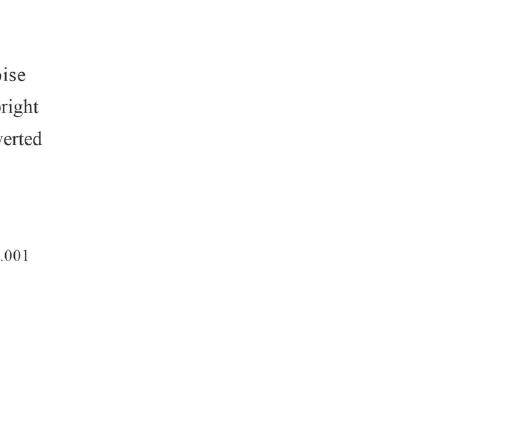
Figure 7. Group*Response interaction for the Toast test. Post-hoc contrasts based on Response. Upper part of the figure: RTs of pareidolia responses versus noise detections were not significantly different in the 40Hz-tACS_ PRE group, while participants in the Sham and 40Hz-tACS_ON groups exhibited differential performances (i.e., significantly faster RTs for face detections vs. noise detections); bottom part of the figure: differences (in absolute values) between noise detections’ and face detections’ RTs among groups (40Hz-tACS_PRE =|6|; Sham =|16|; 40Hz-tACS_ON =|15|).